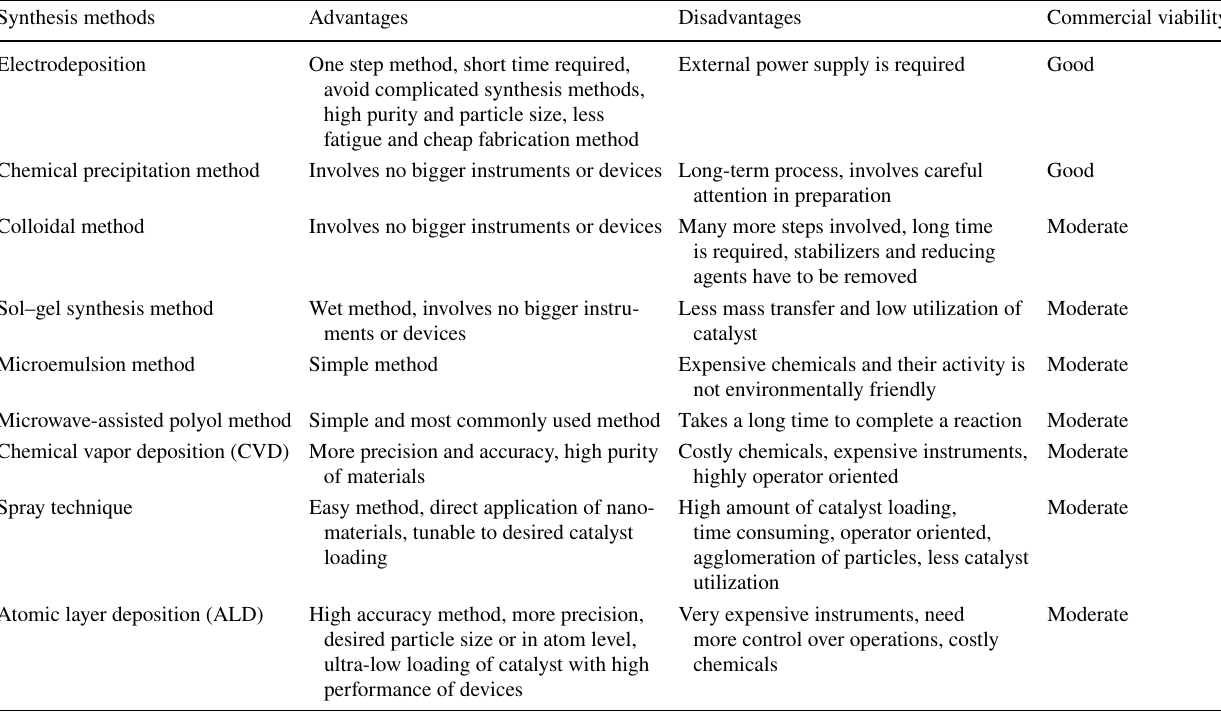
Table 1 Summary of different synthesis methods as discussed in “Most promising methods for the preparation of electrodes” to “Atomic layer